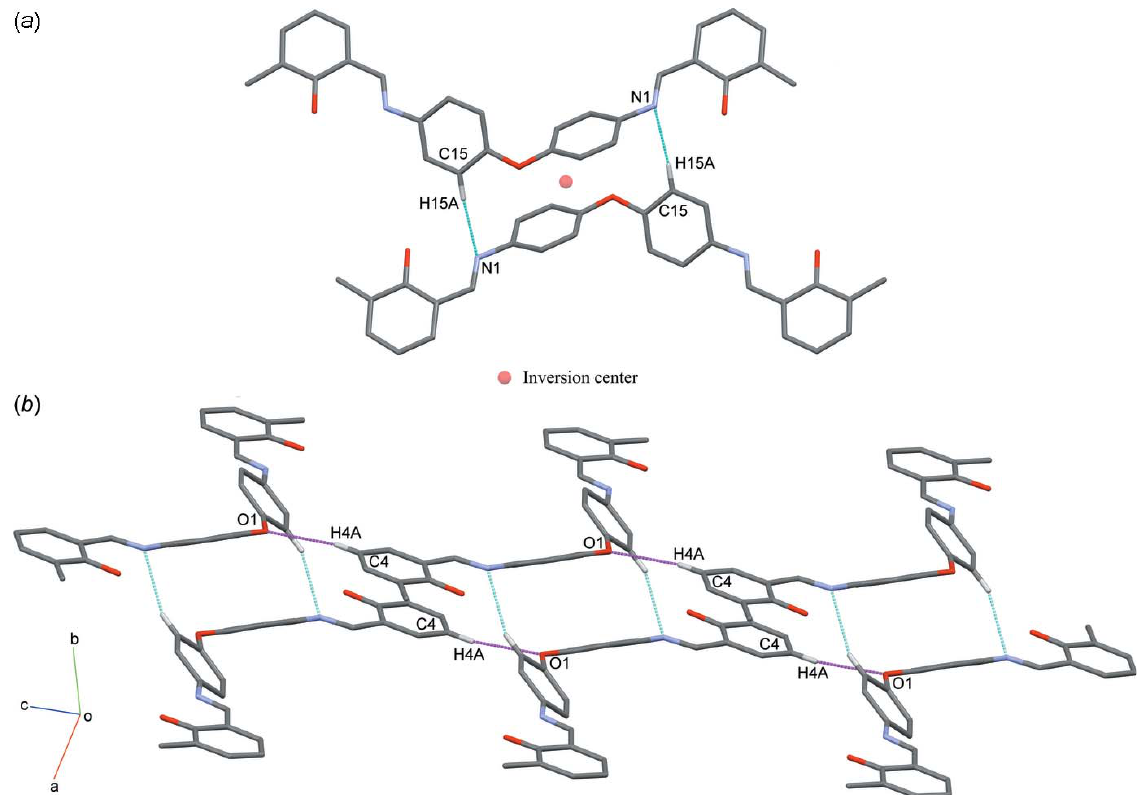
Figure 2 ( a ) Aview of a centrosymmetric dimer of C 28 H 24 N 2 O 3 with weak intermolecular C15—H15 A (cid:2)(cid:2)(cid:2) N1 interactions shown as cyan dotted lines. ( b ) Aview of a dimeric chain with weak intermolecular C4—H4 A (cid:2)(cid:2)(cid:2) O1 shown as megenta lines. Hydrogen atoms not involved in with these interactions are omitted for clarity.